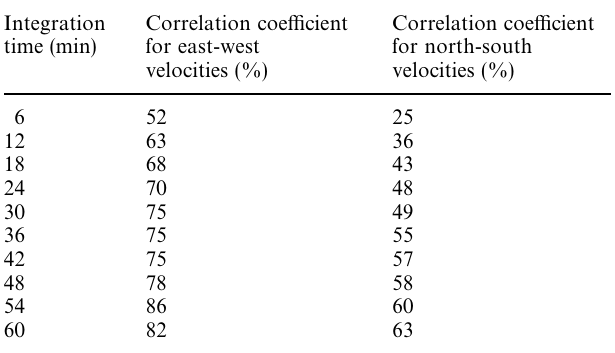
Table 2. Correlation between EISCAT and Dynasonde measure- ments of plasma velocity during the experiment CP-1-K, 8 — 9 June